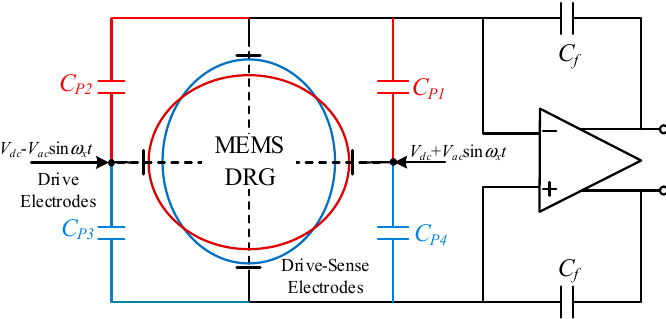
Figure 6. DRG drive signal coupled to drive-sense electrodes.